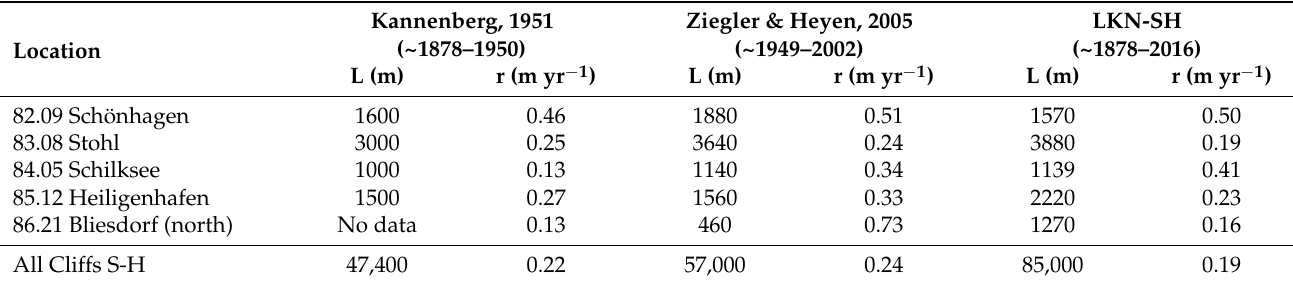
Table 1. Length L (m) and yearly retreat rates r (m yr − 1 ) for the selected cliff sections and compiled for all active S-H cliffs (all local values shown in Table A1).